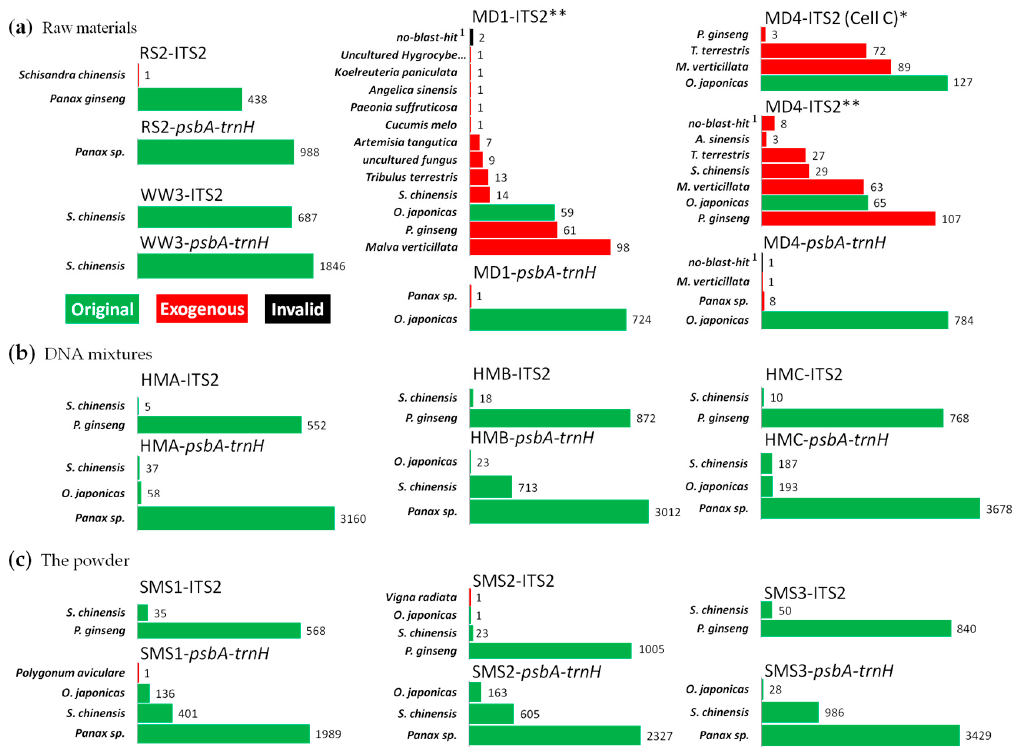
Figure 2. Analysis results on Sheng-Mai-San by full-length multi-barcoding. ( a ) Representative results of the raw materials; ( b ) and ( c ), results of the HSM and SMS, respectively. **, PCR cycles were 35 + 10; *, PCR cycles were 35. Panax sp. , reads that cannot BLAST to certain species in genus of Panax; no-blast-hit 1 , resulting reads that with Max. score < 400 or Identities < 90% for top hits in BLAST.